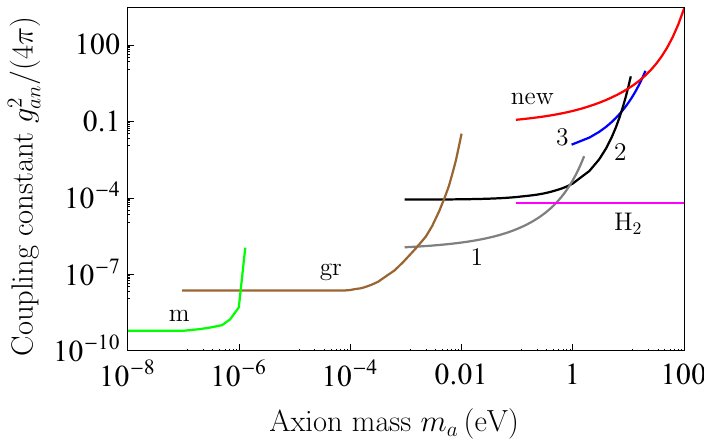
Figure 8. The constraints on the coupling constant of axion to nucleon following from recent measuring the Casimir force at nanometer separations (line labeled “new”), from the magnetometer measurements (line labeled “m”), from the Cavendish-type experiment (line labeled “gr”), and from the experiment using beams of molecular hydrogen (line labeled “H 2 ”) are shown as functions of the axion mass. The lines 1–3, where line 1 indicates the strongest constraints within some range of axion masses, are reproduced from Figure 6. The regions above each line are excluded and below each line are